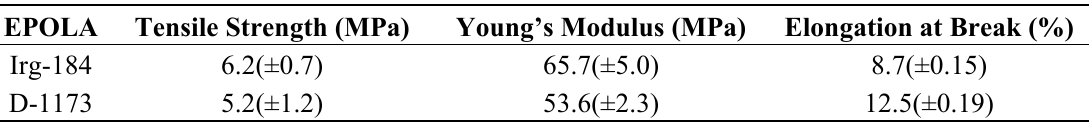
Figure 13. Stress-strain Curves of EPOLA Films Containing Irg-184 and D-1173 Photoinitiators. Table 5. Tensile strength, Young’s Modulus and Elongation at break of EPOLA Films Containing Irg-184 and D-1173